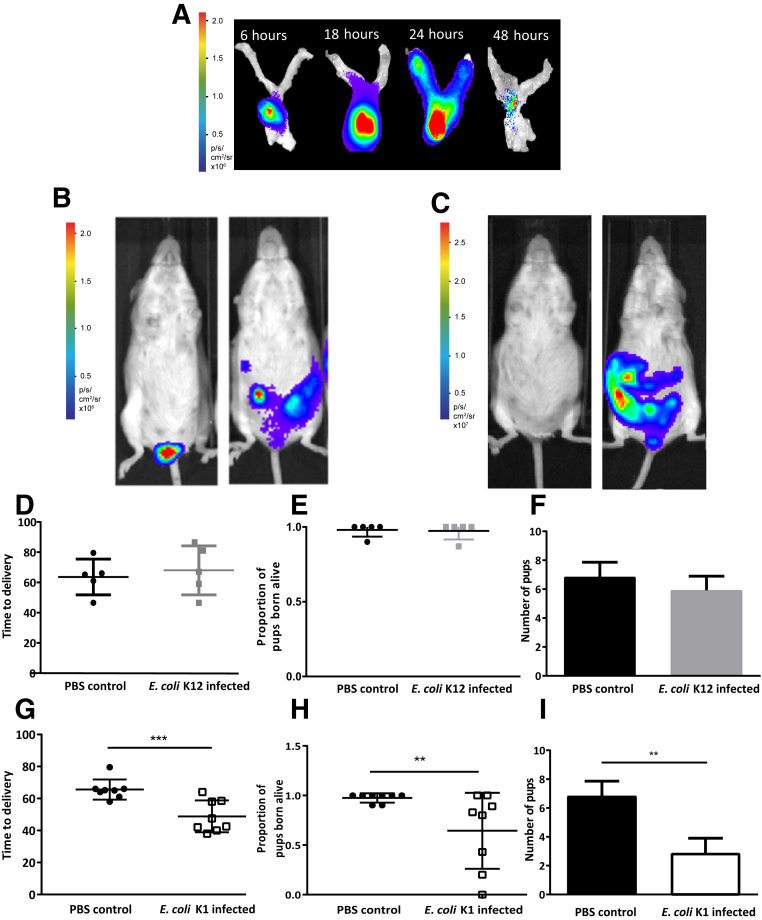
Nonpathogenic Escherichia coli K12 and pathogenic E. coli K1 can ascend into the pregnant uterine cavity, leading to premature delivery in the E. coli K1 group. A: Nonpregnant mice received intravaginal E. coli K12 bacteria and the time course of bacterial ascent was visualized in the nonpregnant reproductive tract. Bacteria traversed the cervix and ascended into the uterine horns by 18 hours and reached the top of the uterine horns by 24 hours. B: In pregnant mice, E. coli K12 bacteria ascended into the pregnant uterine cavity by 24 hours. C: After E. coli K1 administration, bacteria ascended into the pregnant uterine cavity over 24 hours. D–F: Time to delivery (D), the proportion of pups born alive (E), and litter size (F) were determined in dams who received intravaginal phosphate-buffered saline (PBS) or intravaginal E. coli K12. G–I: Time to delivery (G), the proportion of pups born alive (H), and litter size (I) were determined in dams who received intravaginal PBS or intravaginal E. coli K1. Data are expressed as means ± SEM (F and I). n = 5 (A–D); n = 8 (E–I). ∗∗P < 0.01, ∗∗∗P < 0.001.